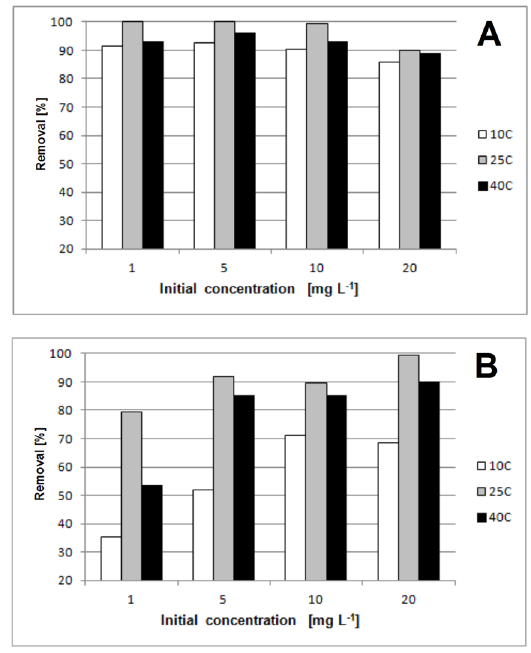
Figure 3. The effect of temperature on biosorption of Pb (A) and Cd (B) sorption after 3 h and 6 h of contact, respectively.